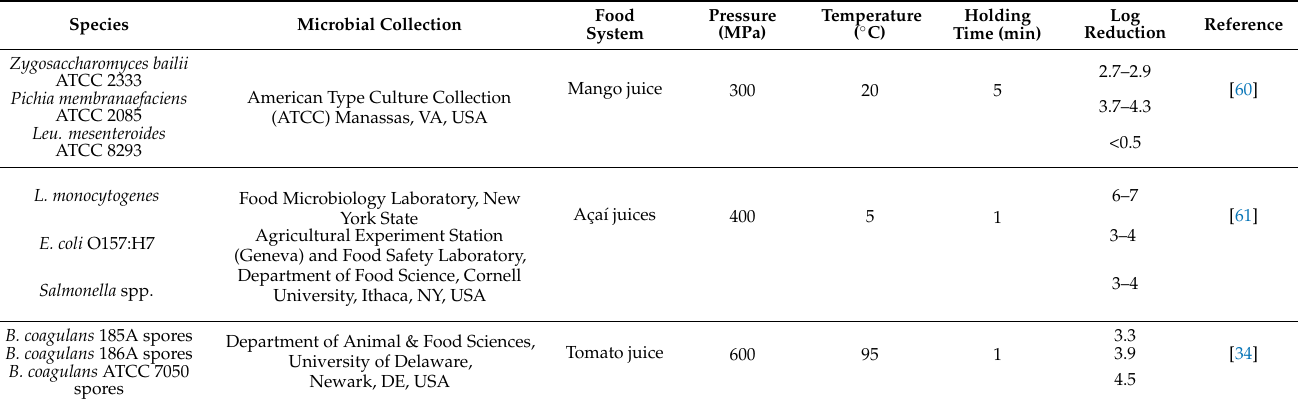
Table 2. Inactivation effect of HPP on different kinds of microorganisms in the same food